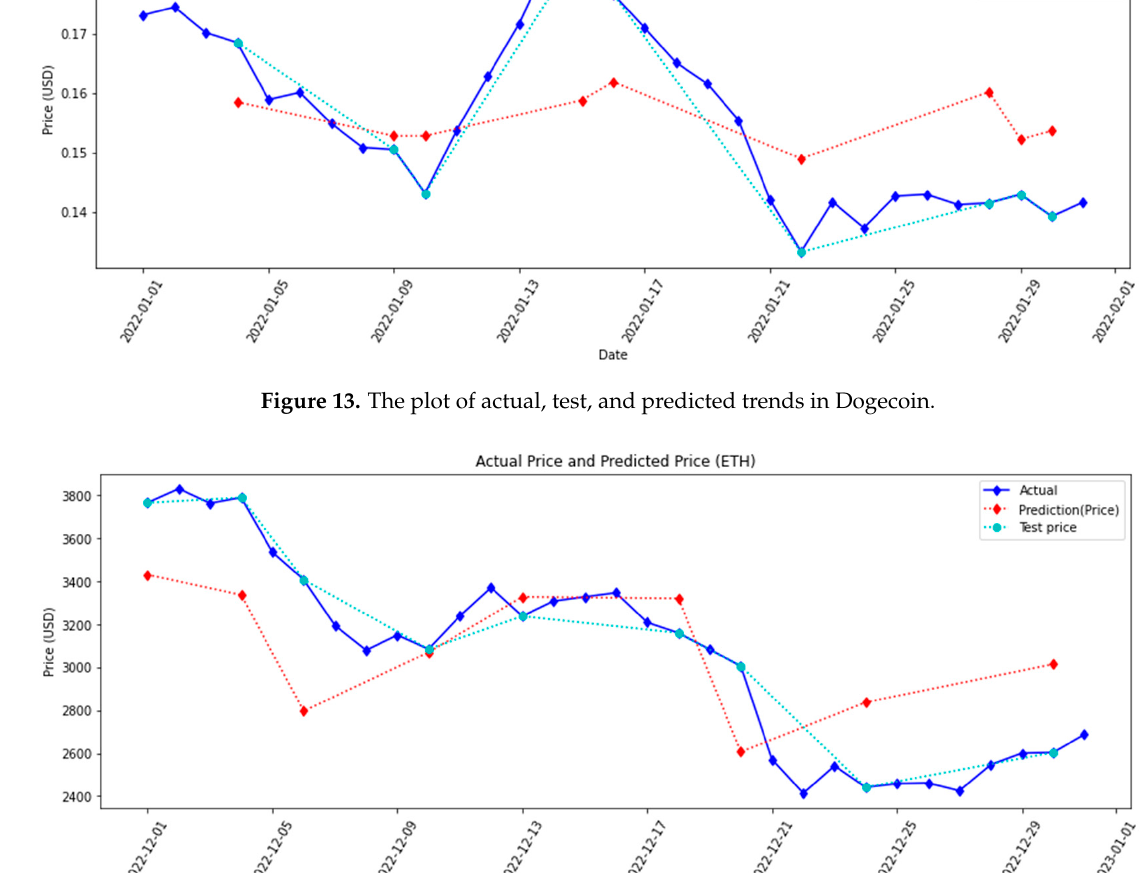
Figure 15. The plot of tested vs. predicted trend in Bitcoin. Figure 16. The plot of tested vs. predicted trend in Dogecoin.